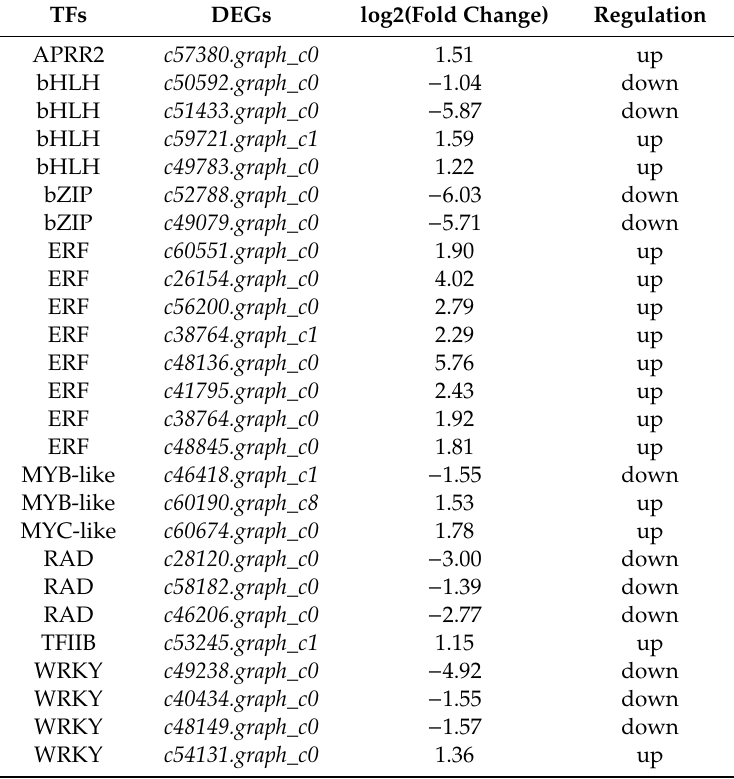
Table 6. Transcription factors (TF) regulating fruit